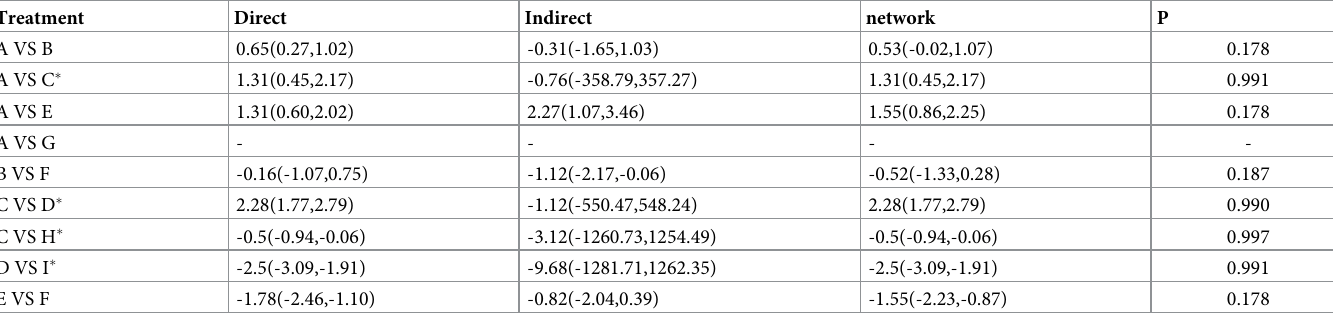
Table 2. Node splitting result of VAS.